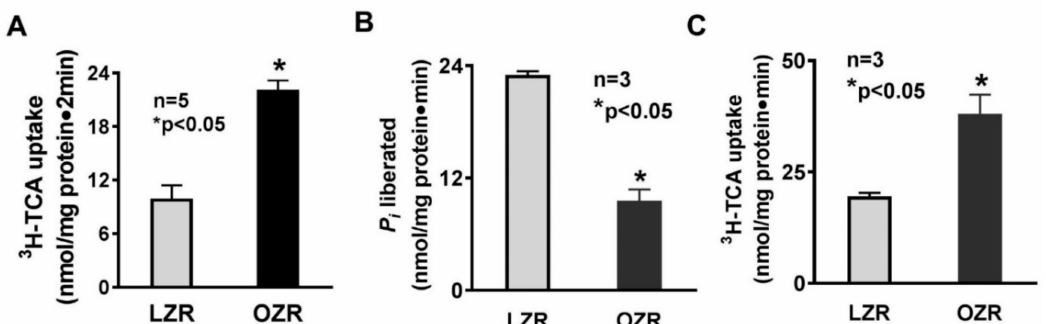
Figure 1. Na–bile acid cotransport and Na-K-ATPase in Zucker rat villus cells. ( A ) Na-dependent bile acid ( 3 H-taurocholate or TCA) cotransport was significantly increased in intact villus cells from obese Zucker rats (OZR) compared to lean Zucker rats (LZR). ( B ) Na-K-ATPase activity was significantly reduced in villus cell homogenates from OZR. ( C ) Villus cell BBM Na–bile acid cotransport was also significantly increased in OZR.